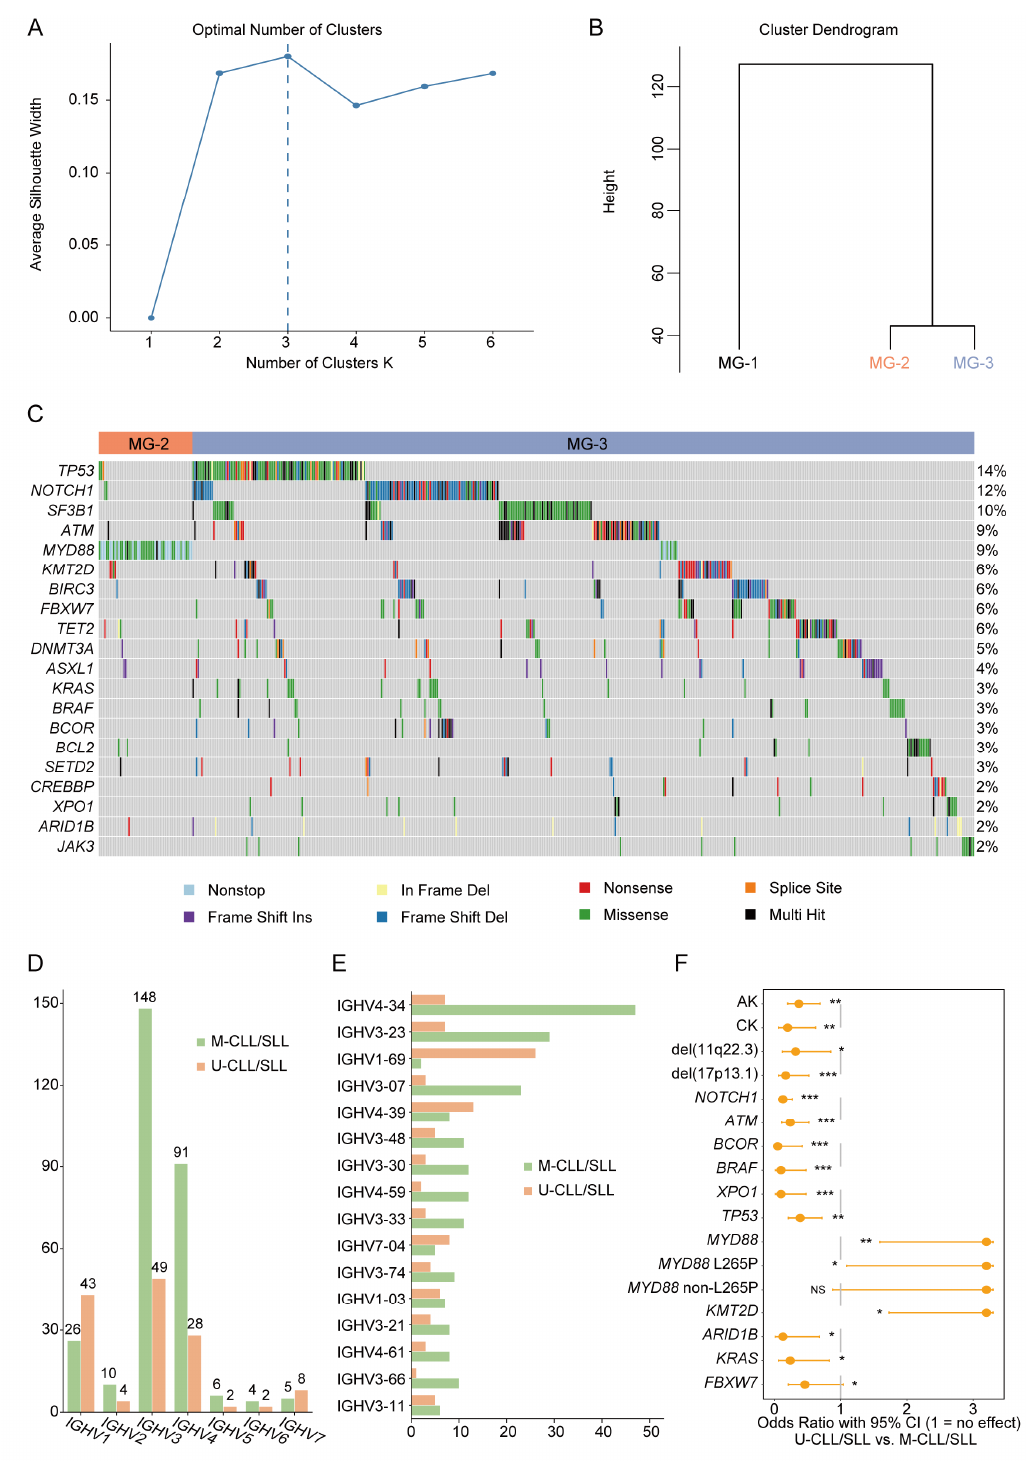
Figure 1. Genetic abnormalities and IGHV family and subfamily usage in CLL/SLL. ( A ) Optimal number of clusters based on the highest silhouette value. ( B ) Three novel molecular subgroups unveiled through unsupervised genomic analysis. ( C ) Variant landscape of 761 newly diagnosed CLL/SLL patients. ( D ) IGHV family usage and distribution. ( E ) IGHV subfamily usage and distribution. ( F ) Genetic abnormality differences between IGHV M-CLL/SLL and IGHV U-CLL/SLL. M-CLL/SLL: hypermutated IGHV CLL/SLL; U-CLL/SLL: non-hypermutated IGHV CLL/SLL; AK: abnormal karyotype; CK: complex karyotype; ***: p value < 0.001; **: p value < 0.01; *: p value < 0.05; NS: no signi fi cance.